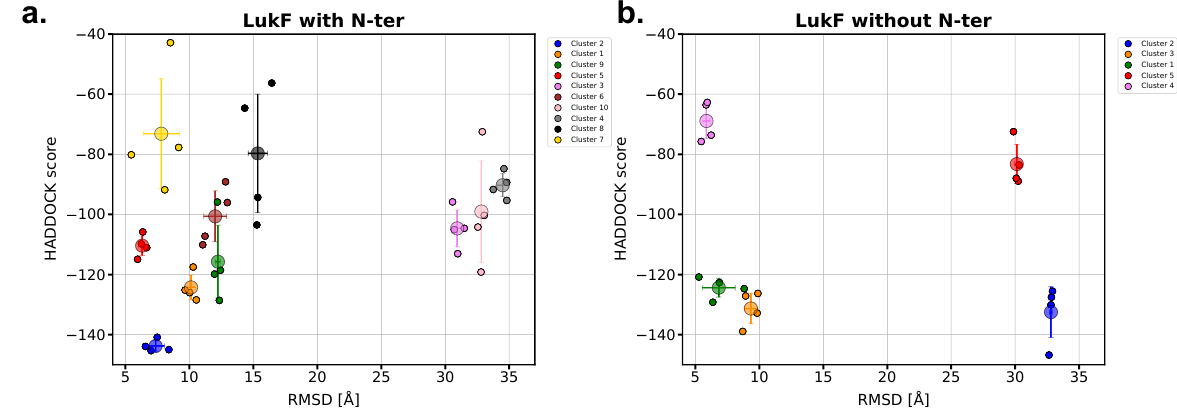
Figure 5. Plots of the HADDOCK scores of the predicted LukF-Hlg2 dimers (in the presence ( a ) and absence ( b ) of the LukF amino-latch) and their RMSD computed with respect to the same dimer extracted from the crystal structure of the pore. Each color represents a specific cluster of structures generated by HADDOCK. For each cluster, the data referring to the four top-scored structures (small circles) are shown, along with their average values and standard deviations (larger circles with